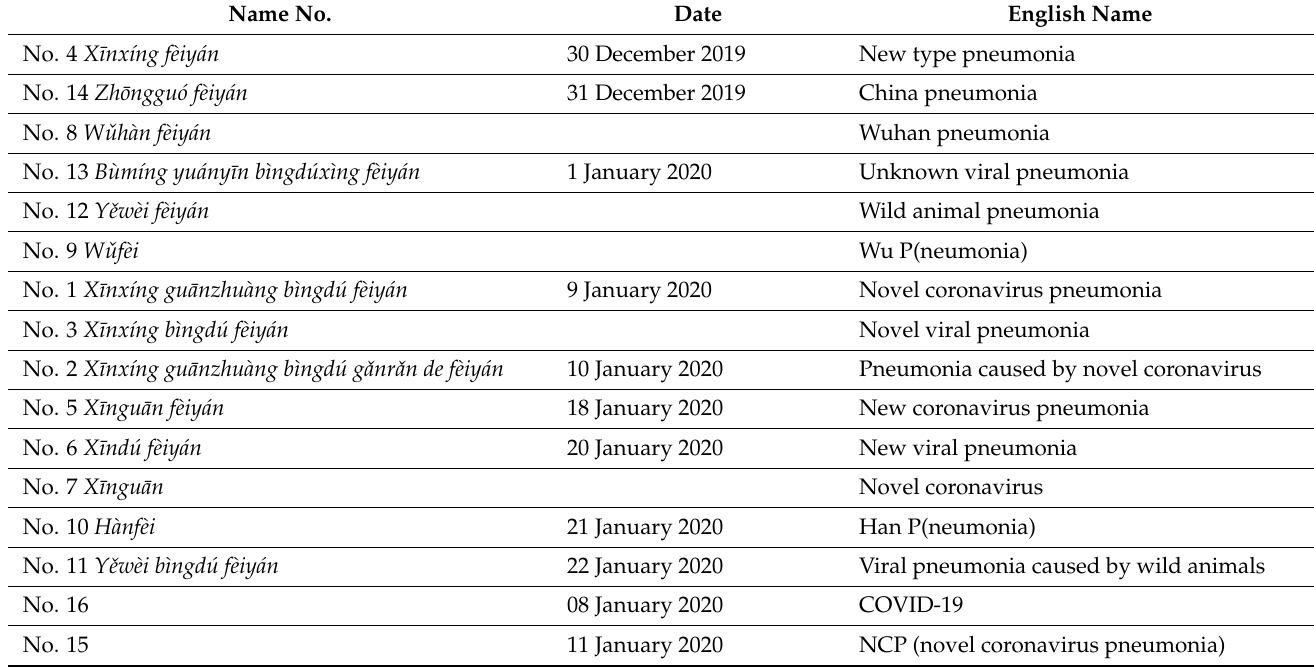
Table 2. List of coronavirus disease names according to date of first occurrence; coronavirus disease name survey 2020. Name